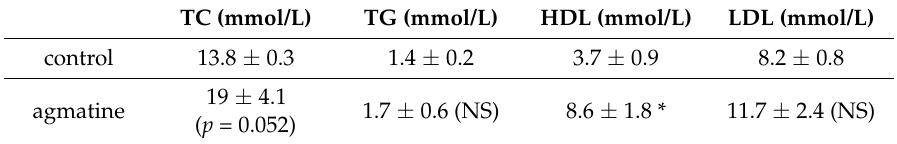
Table 2. Vascular Cell Adhesion Protein 1 (VCAM-1), Interleukin-12 (IL-12), Monocyte Chemoattractant Protein 1 (MCP-1), and Serum Amyloid A (SAA) in a control and agmatine-treated groups, presented as mean ± SD.